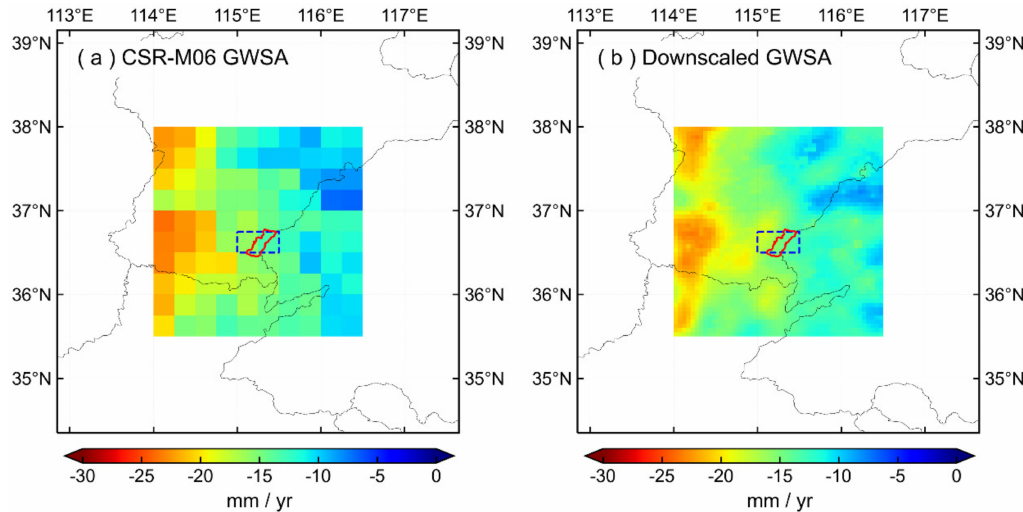
Figure 11. Spatial distribution of GWSA trend ( a ) before and ( b ) after downscaling in WS5.